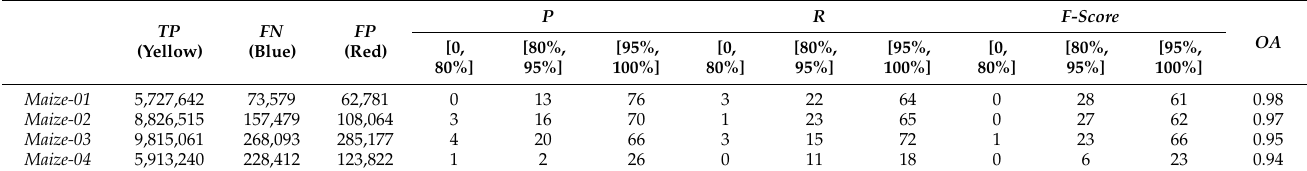
Table 3. Individual maize segmentation result statistics table.